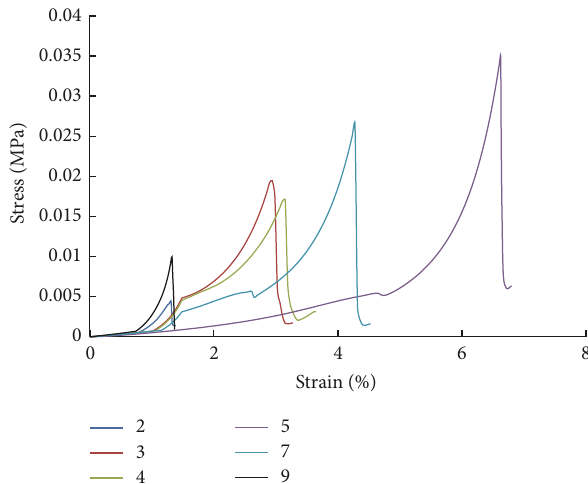
Figure 6: The compressive stress/strain capacity curves of octadecyl methacrylate-acrylamide- N,N 󸀠 -bis(acryloyl)-cystamine (octadecyl methacrylate concentration: 2%, 3%, 4%, 5%, 7%, and 9%).